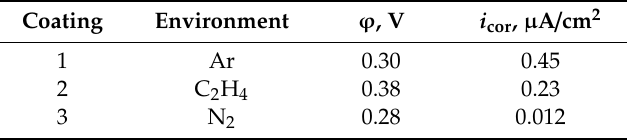
Figure 7. Polarization curves for the coatings in linear ( a ) and semi-logarithmic ( b ) coordinates. The free corrosion potential ϕ and corrosion current density i cor are shown in Table 3. Table 3. Electrochemical properties of coatings.